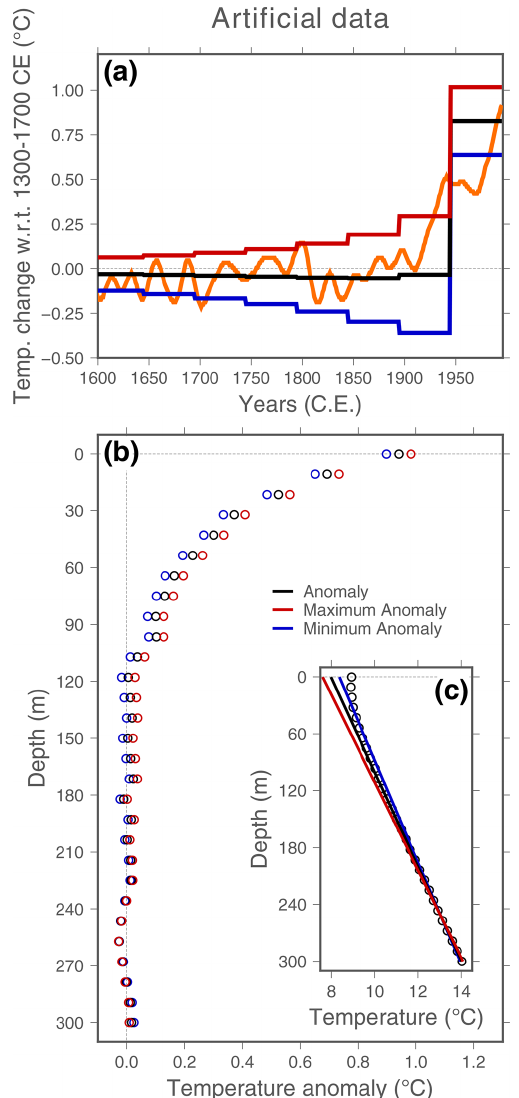
Figure 1. (a) Surface signal (orange line) and corresponding anomaly (b) and original (c) profiles for the artificial case. The surface signal corresponds to the PAGES2k-Land temperatures de- scribed in the Data section. The subsurface temperature profiles re- sult from the propagation of the surface signal through the ground using a purely conductive forward model (see Methods section), considering a quasi-equilibrium profile given by a long-term sur- face temperature of T 0 = 8 ◦ C and a geothermal gradient of (cid:48) = 0 . 02 ◦ Cm − 1 . Gaussian noise with µ = 0 . 0 ◦ C and σ = 0 . 02 ◦ C is added to simulate measurement error. The extremal profiles (red and blue data) are estimated from a linear regression analysis of the deeper 100 m of the profile. The intercept of the extremal profiles in (c) has been modified for clarity. Temperature reconstructions from SVD inversions of each anomaly profile in (b) are shown in (a)